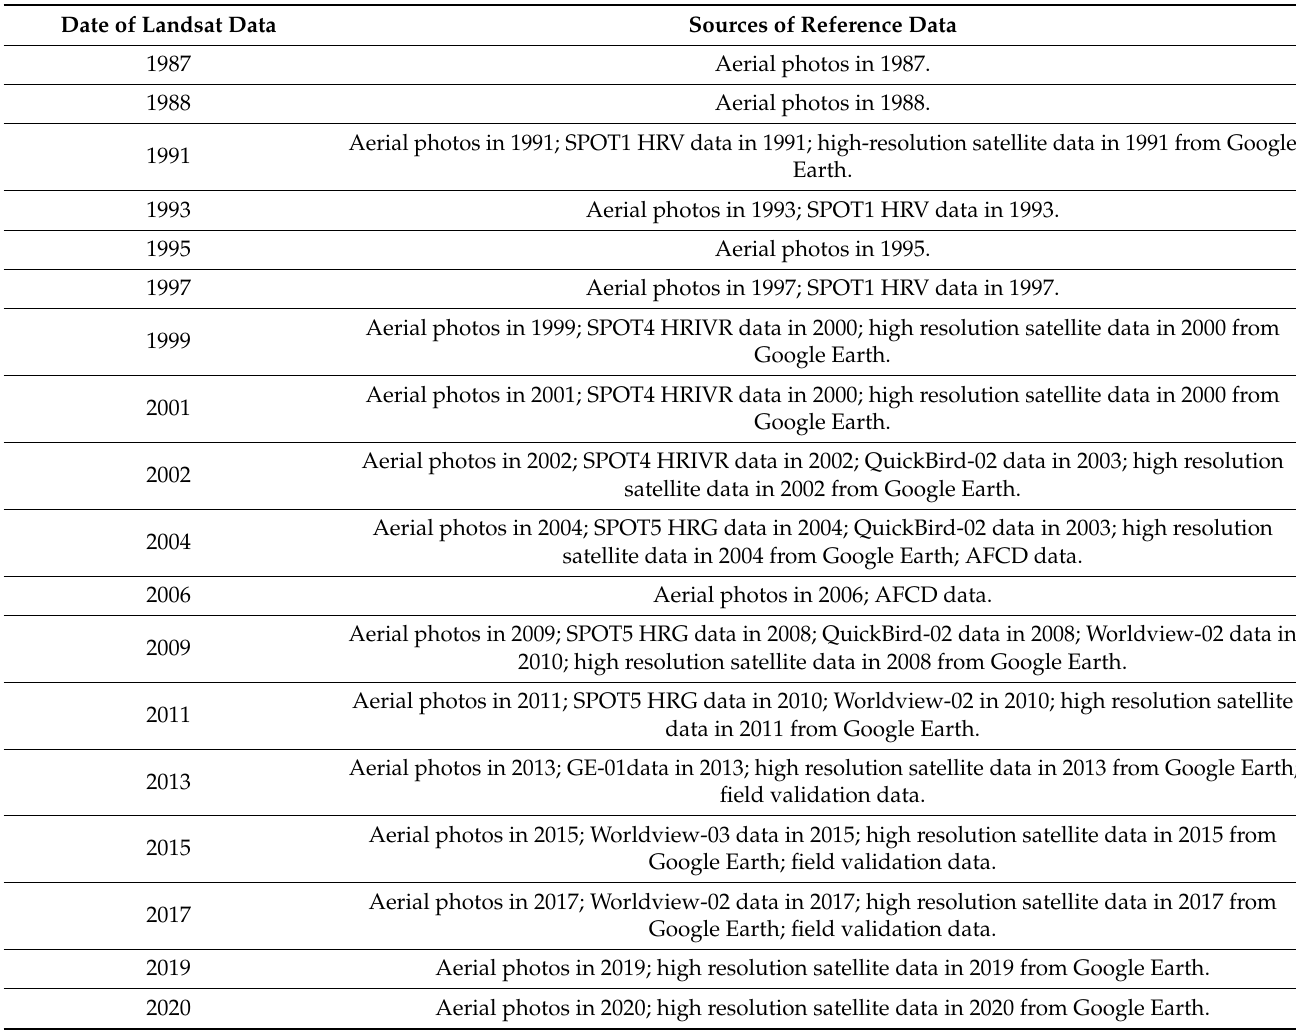
Table 3. Reference data sample selection in this